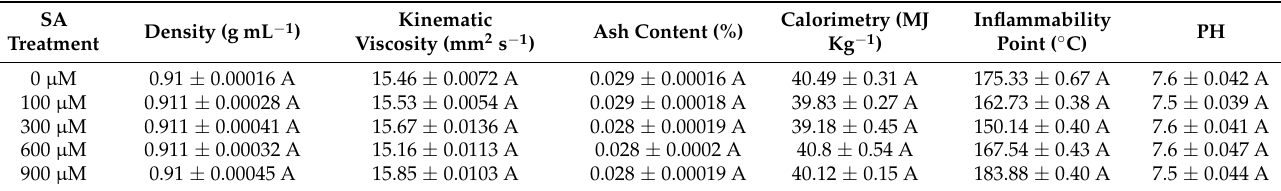
Table 3. Physicochemical properties of Ricinus communis biodiesel.